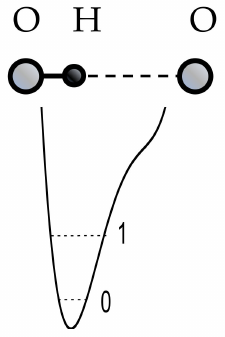
Figure 1. Proton potential function for a weak hydrogen bond, d O ··· O ≥ 2.7 Å.